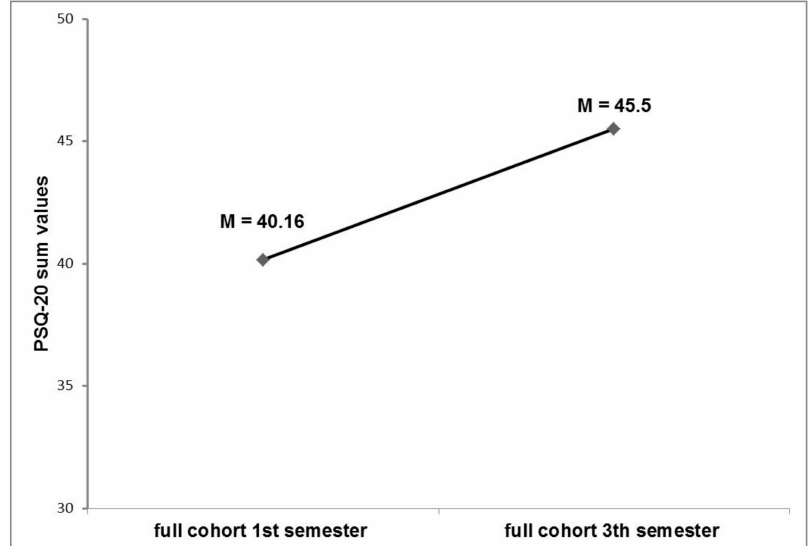
Figure 3. Perceived stress in full cohorts of medical students. M = mean values for PSQ-20 sum-score values of two full cohorts of medical students at comparable study levels to the measurement time points of the prospective evaluation of the tandem program (C1: freshmen medical students, n = 148; C2: medical students at later study stages (third semester), n = 143).